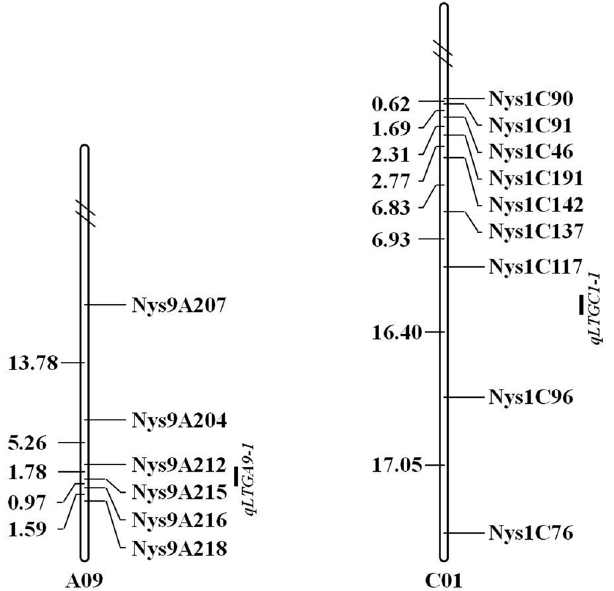
Figure 3. Fine mapping of LTG QTL in F 2:3 families derived from 3429 × Huyou21. The numbers on the left are map interval sizes in Kosambi centiMorgan (cM) units and on the right are the SSR markers on chromosome A09 and